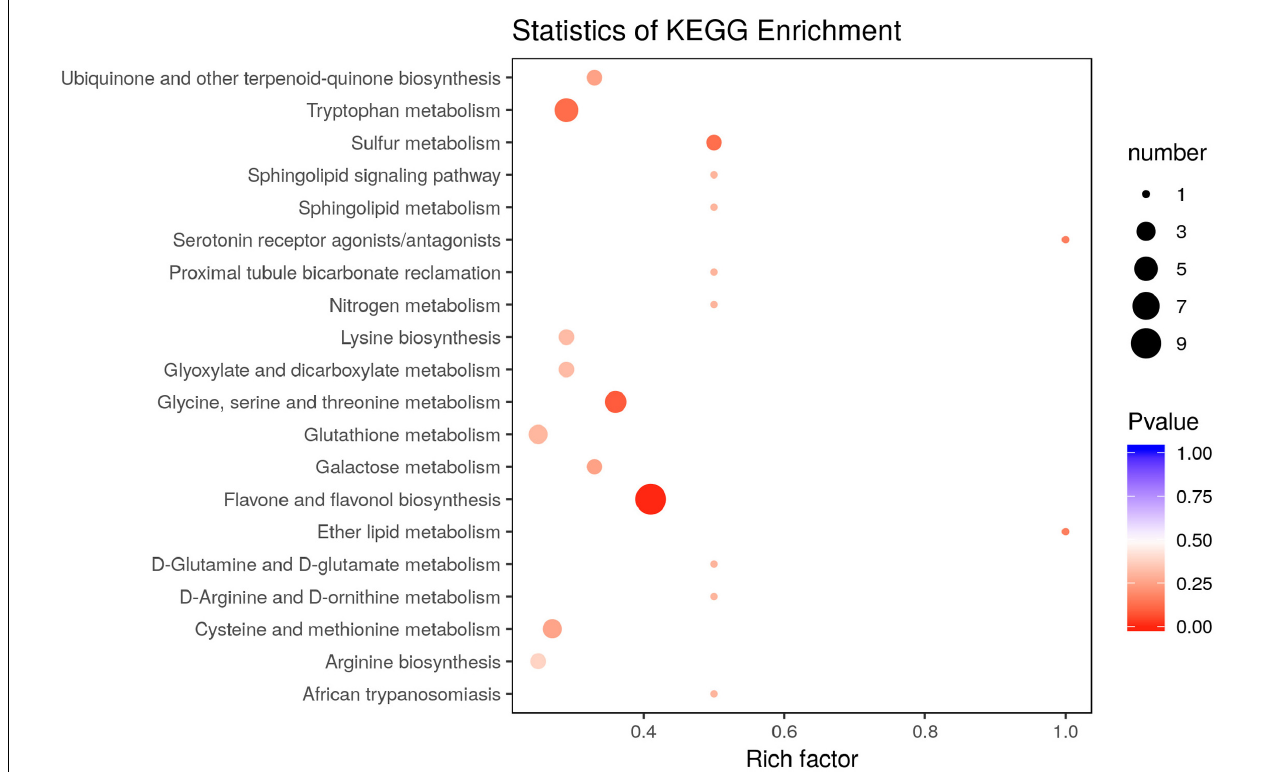
FIGURE 3 | KEGG pathway enrichment of differentially accumulated metabolites (DAMs) in the leaves of Cyclocarya paliurus between low and high